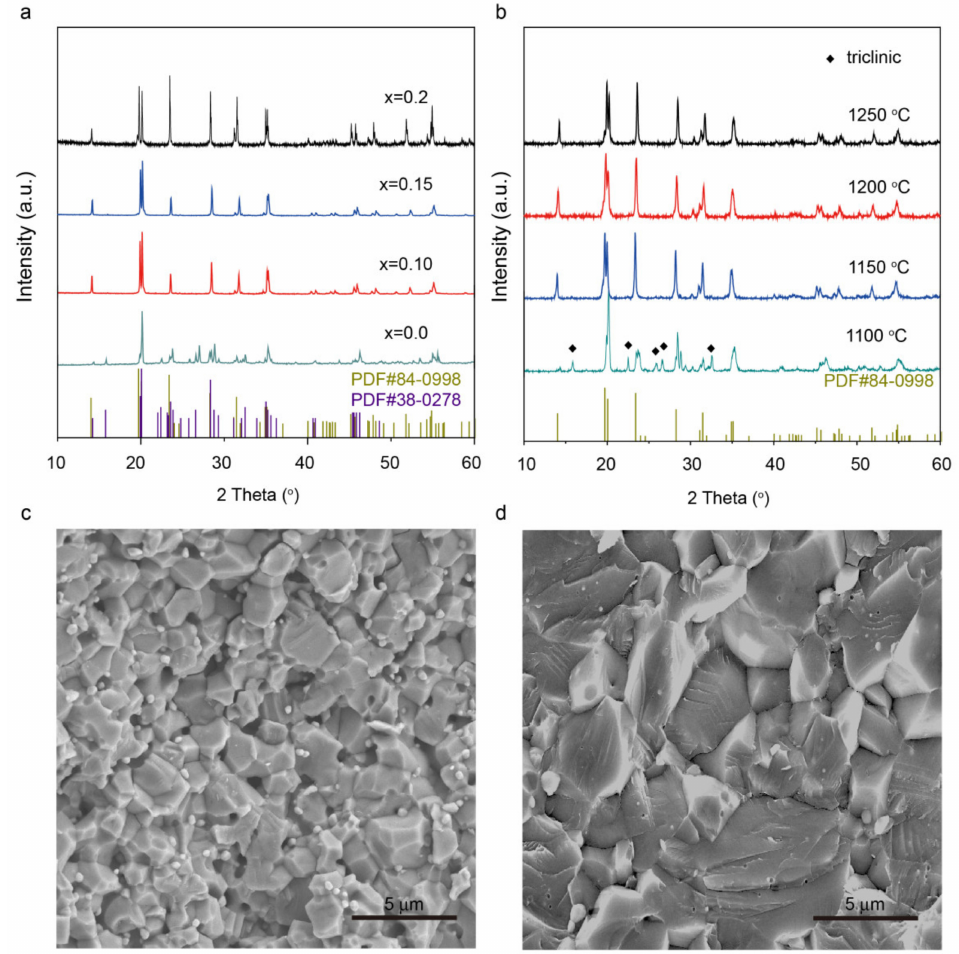
Figure 1. ( a ) XRD patterns of Li 1 + x Y x Zr 2 − x( PO 4 ) 3 (0 ≤ x ≤ 0.2) electrolyte fired at 1150 ◦ C for 12 h. ( b ) XRD patterns of LY 0.1 ZP treated by hot-pressing (HP) at 1100–1250 ◦ C. The cross-section SEM images of LY 0.1 ZP treated by ( c ) regular sintering and ( d ) hot-pressing. PDF #84-0998 and